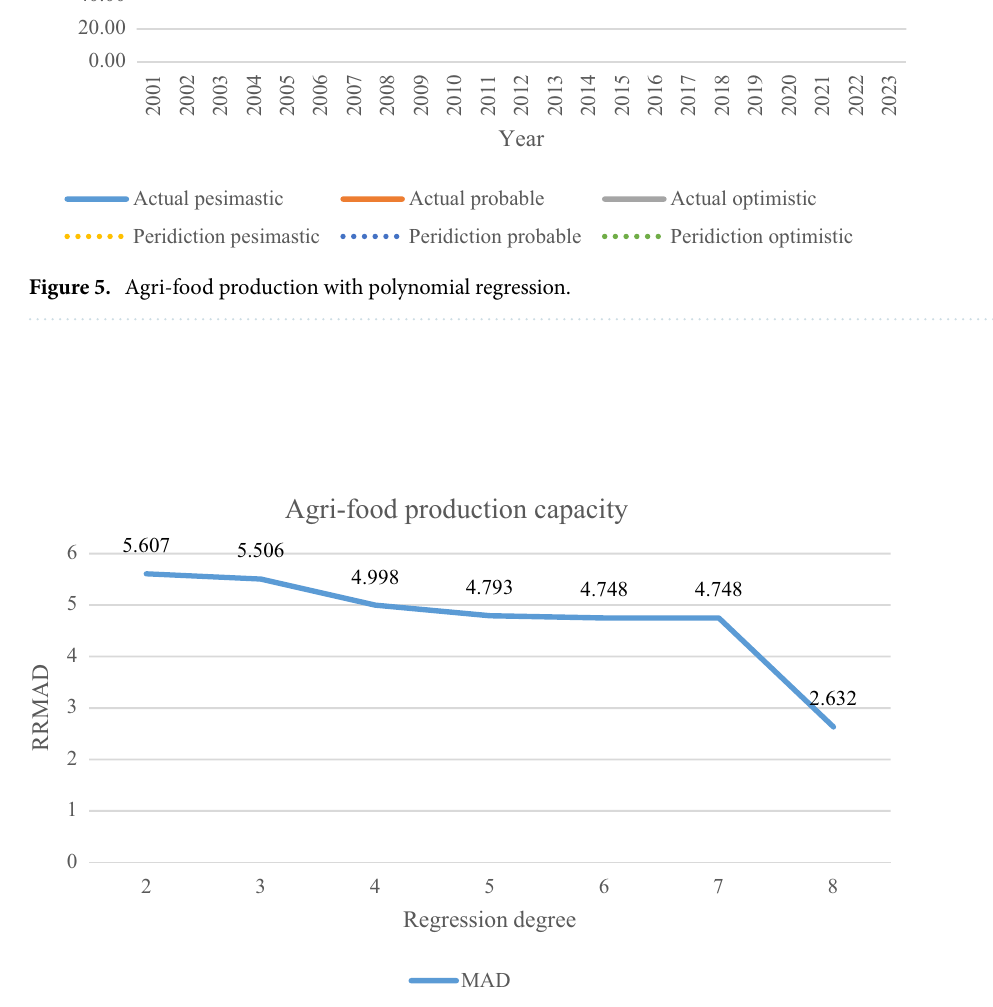
Figure 6. Amount of RRMAD for Agri-food